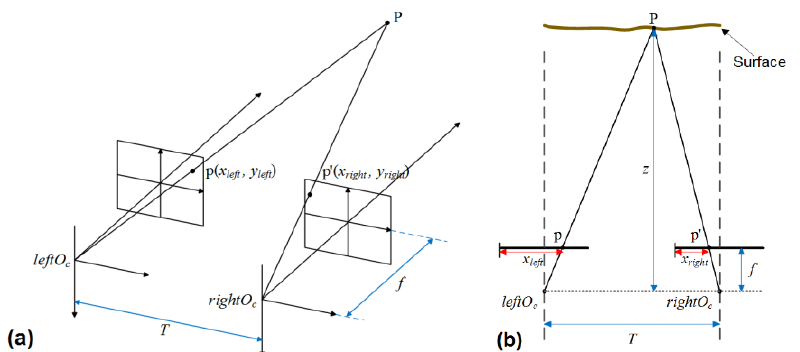
Figure 4. The parallel optical axis binocular system. (a) A simple schematic diagram of parallel optical axis binocular system. (b) The 2D plan of the schematic diagram.